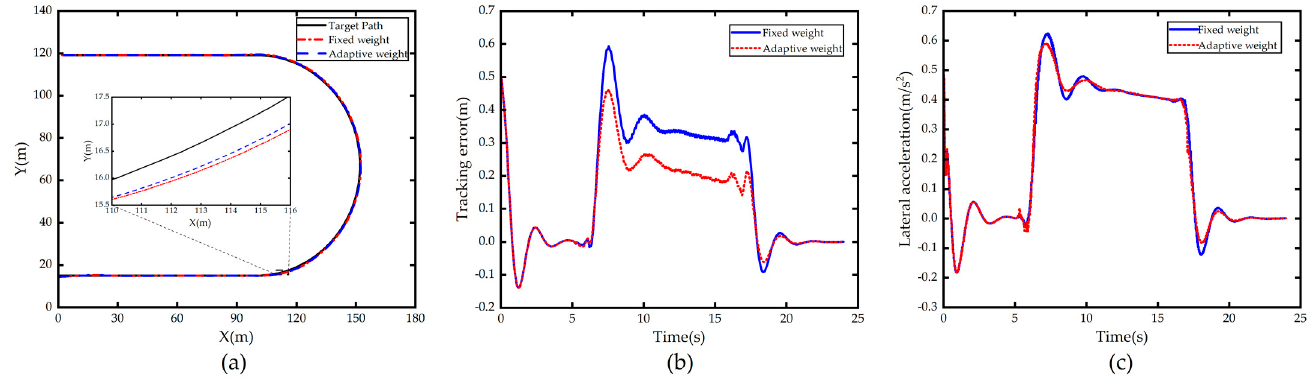
Figure 9. Comparison of 60 km/h simulation results in Scenario 1. ( a ) Path; ( b ) Tracking error; ( c ) Lateral